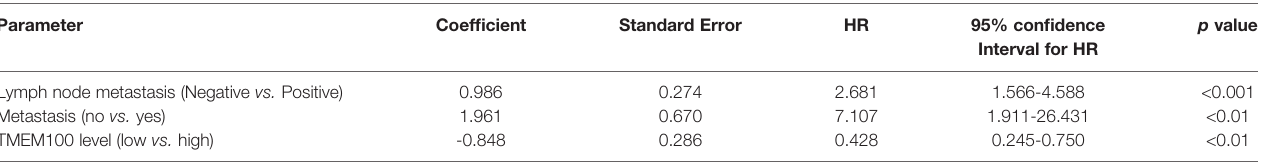
Interval for HR